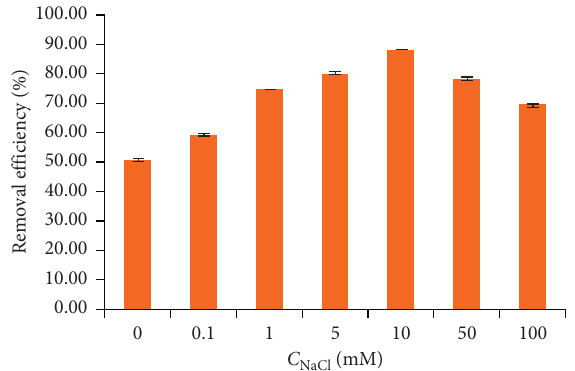
Figure 2: Effect of pH on the TC removal using NCPML ( C (TC) � 10mg/L). Error bars indicate the standard deviations of three replicates.